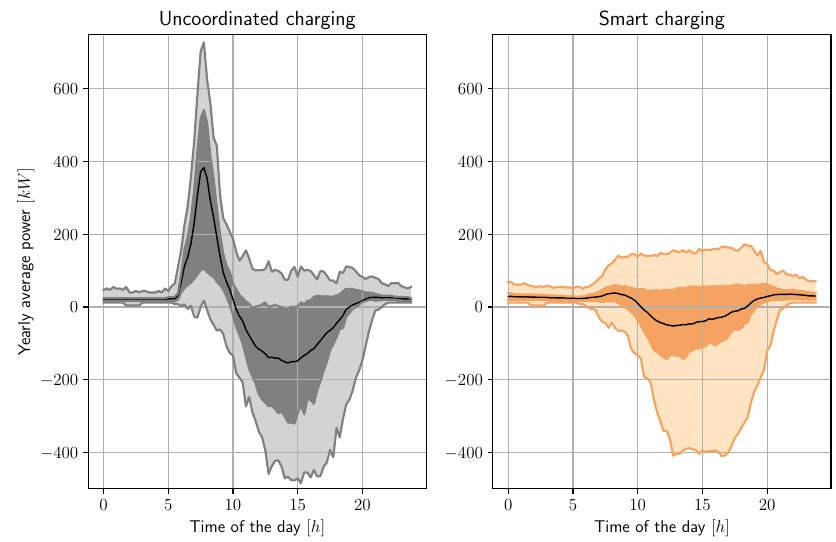
Figure 7. Six-month simulation of uncoordinated and smart